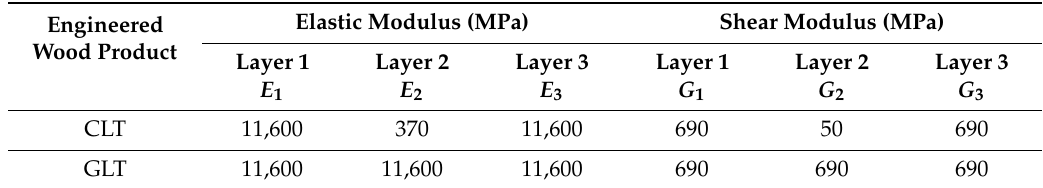
Table 4. Elastic modulus values used for the analytical methods for 3 layered CLT.